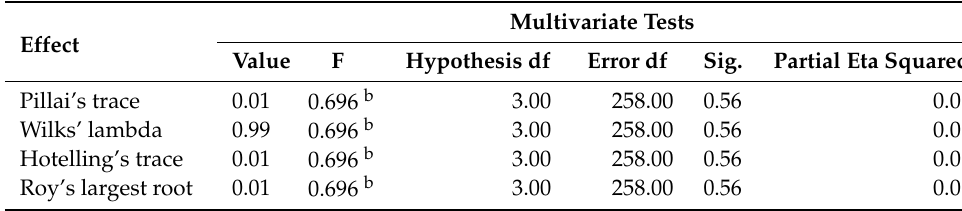
Table 4. Health benefits of adopting biogas technology.